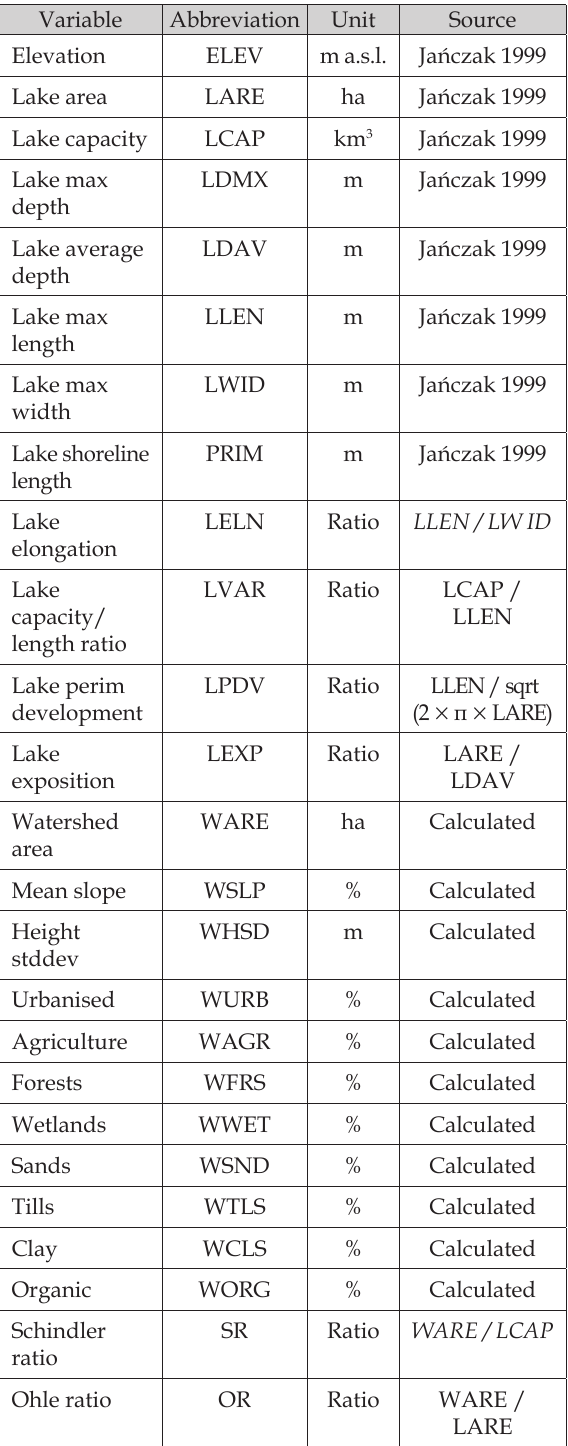
Table 1. Explanatory variables used in the